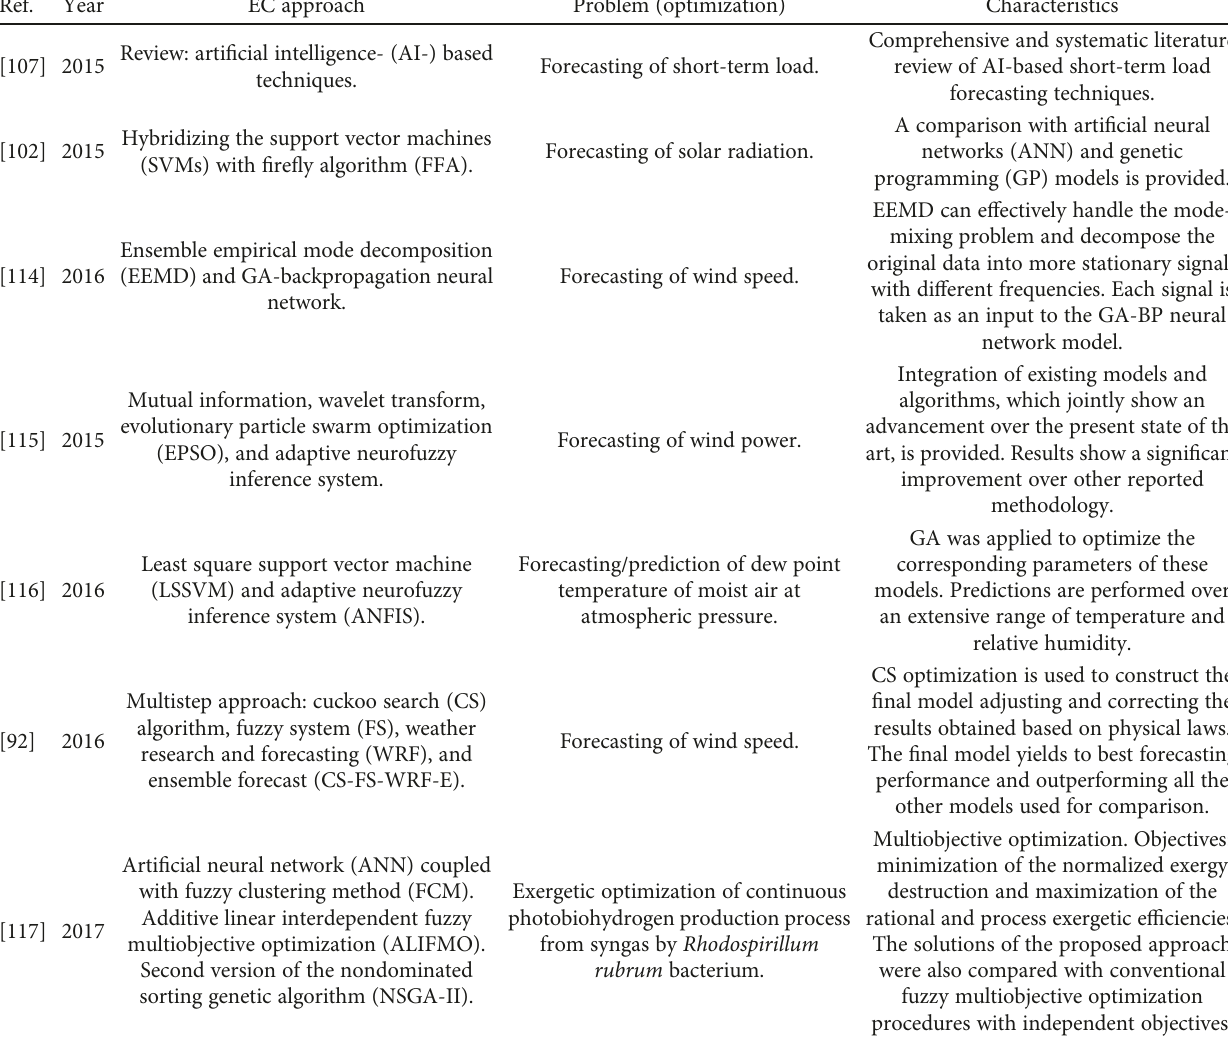
Table 7: Some selected recent highly cited papers of hybrid approaches applied to energy related problems (span of 2015 – 2017).